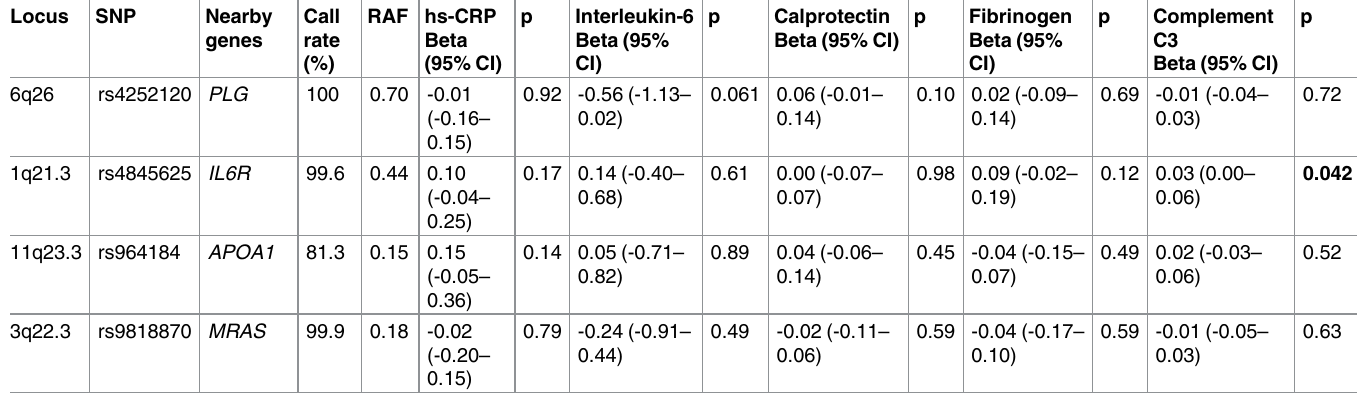
Table 2. Associations between presumed inflammation-related SNPs and inflammatory